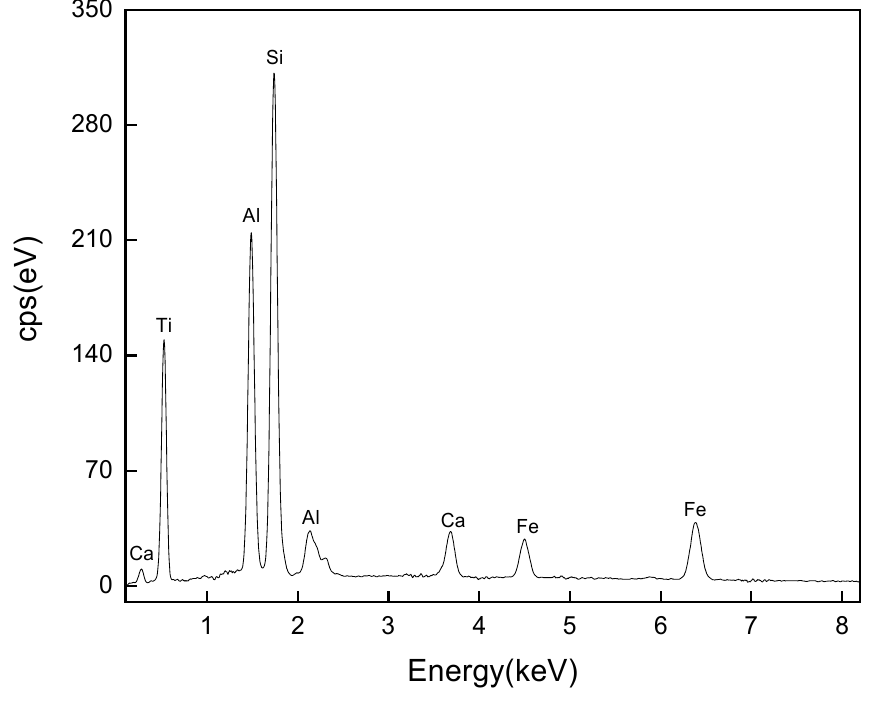
Figure 4. XPS scanning range of coal gangue.